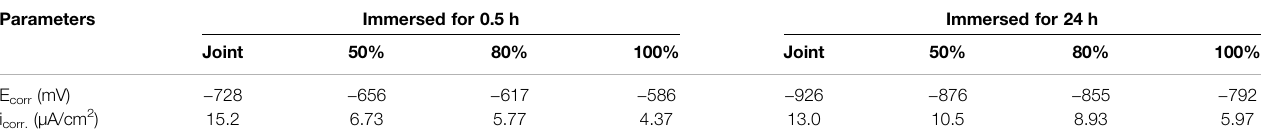
TABLE 4 | The fi tting results of the potentiodynamic polarization curve.